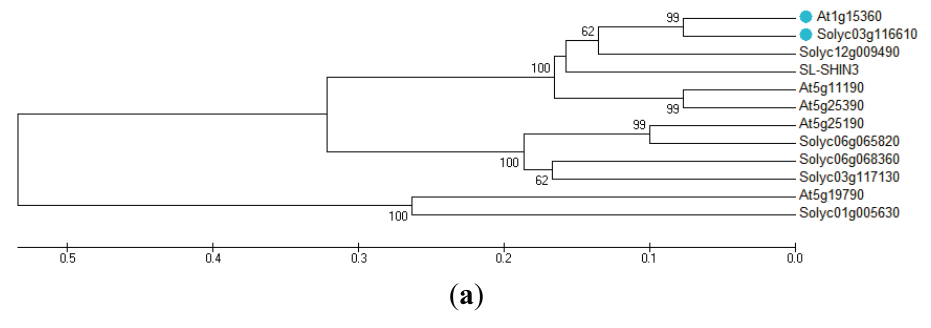
Figure 1. ( a ) Phylogenetic analysis of Arabidopsis proteins belonging to the ERF Gene Family Group Va and ( b ) their closest ortholog in tomato. Multiple sequence alignment analysis of three selected WIN/SHN Arabidopsis proteins (At1g15360 (WIN1/SHN1), At5g11190 (WIN2/SHN2) and At5g25390 (WIN3/SHN3)) with their closest ortholog in tomato (SlSHN1 (Solyc03g116610), SlSHN2 (Solyc12g009490) and SlSHN3) [28]. The AP2 domain is underlined. White letters shaded indicate amino acids that are either 100% identical (black) or identical in at least 80% (dark gray) or identical in at least 60% (light gray) of all